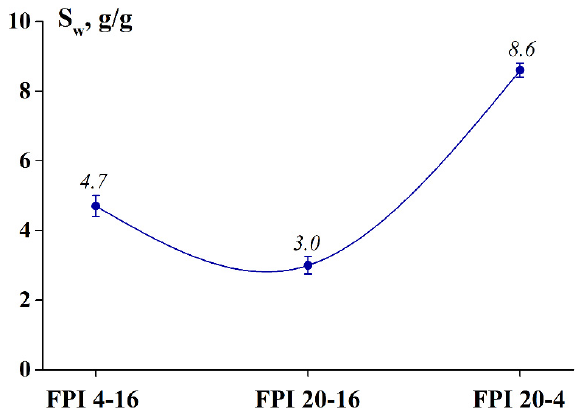
Figure 3. Degree of swelling of fish protein isolates (FPIs) obtained from northern blue whiting under various conditions of alkaline solubilisation.